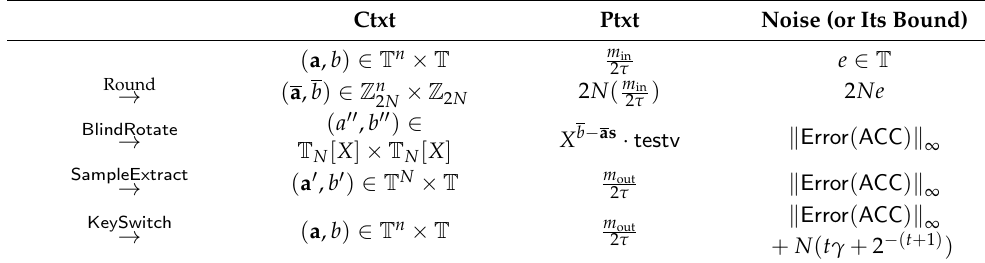
Table 1. Overview of the bootstrapping